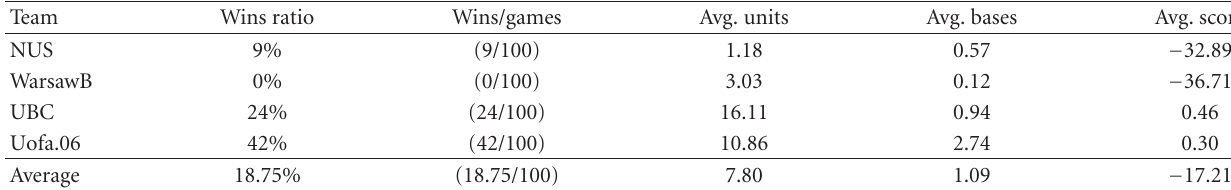
Table 3: Experiment results from increased granularity.